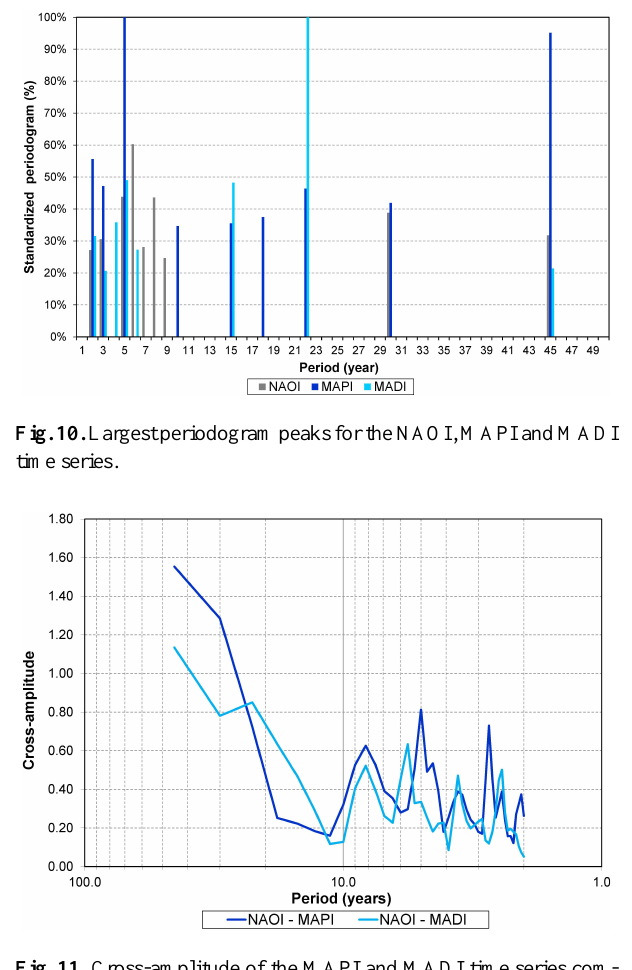
Fig. 11. Cross-amplitude of the MAPI and MADI time series com- pared to the NAOI time